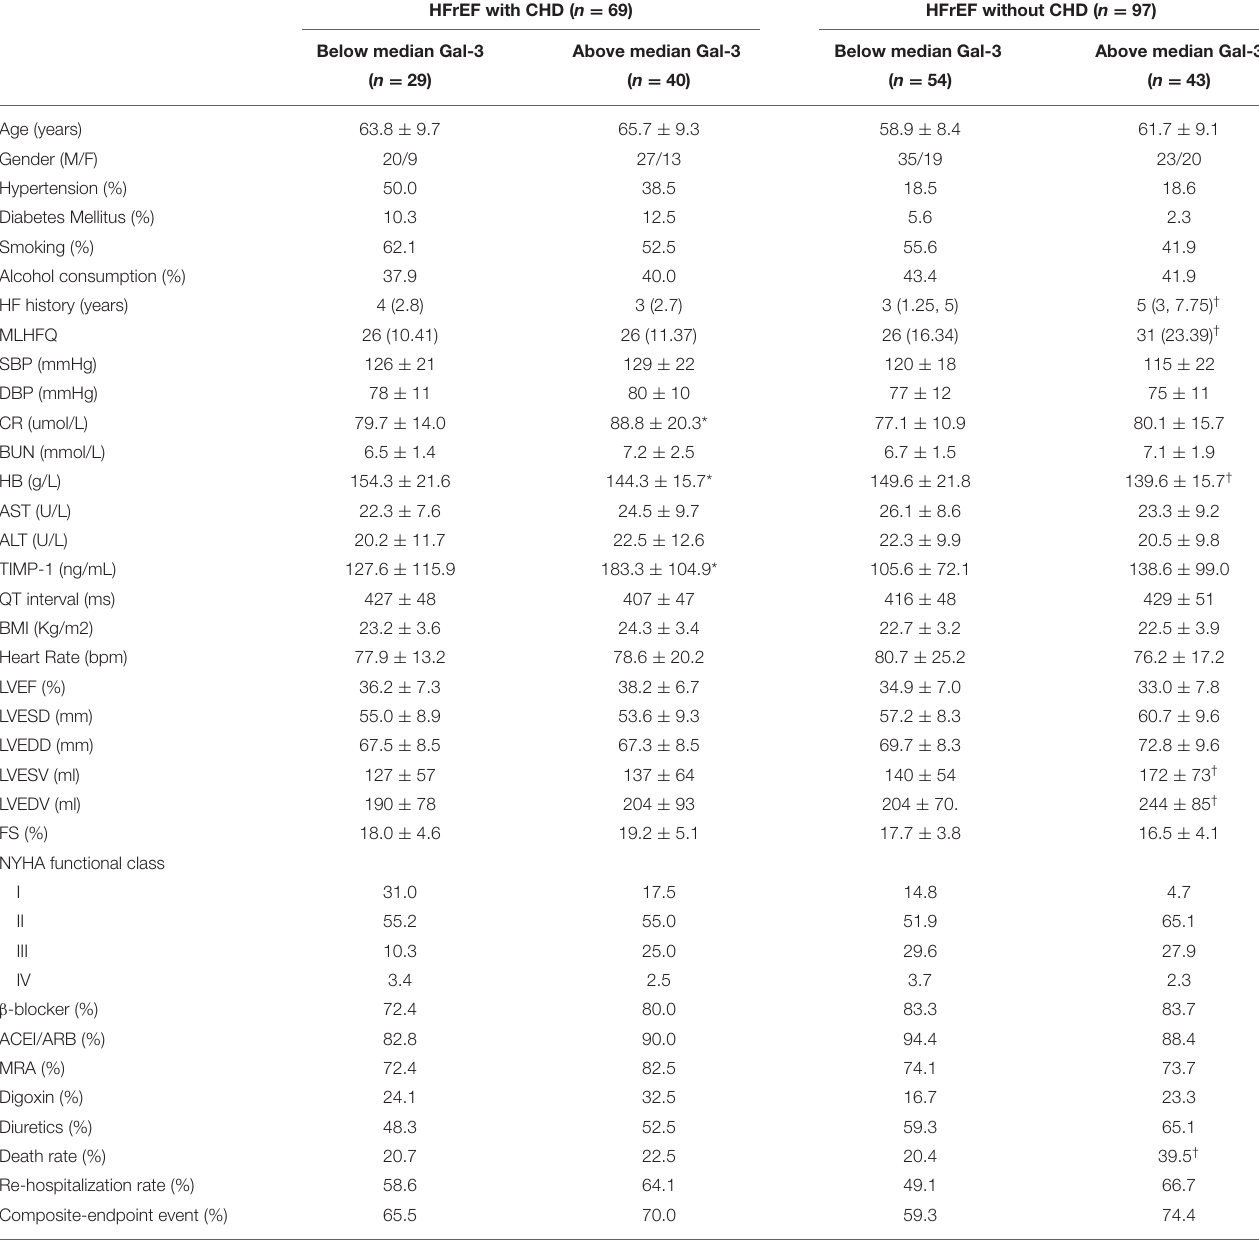
TABLE 3 | Baseline characteristics of HFrEF with or without CHD patients. HFrEF with CHD ( n = 69) HFrEF without CHD ( n = 97) Below median Gal-3 Above median Gal-3 Below median Gal-3 Above median